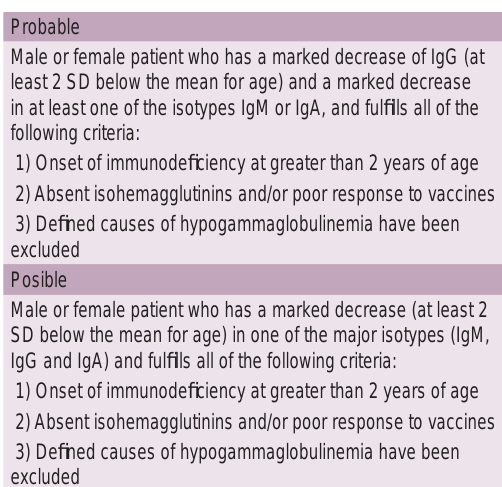
TABLE 2. European Society for the Immunodefi ciency's (ESID) Criteria for the diagnosis of